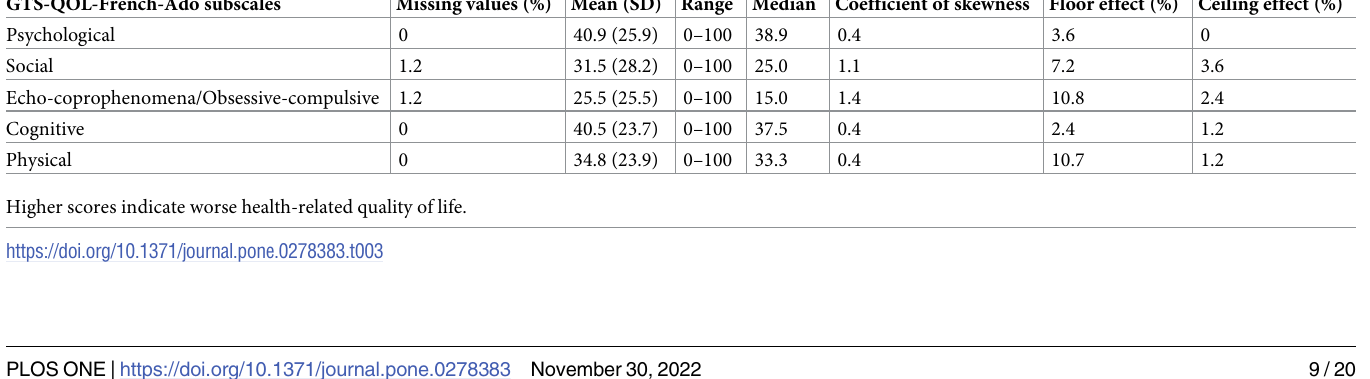
Table 3. Descriptive statistics and score distributions of the GTS-QOL-French-Ado subscales. GTS-QOL-French-Ado